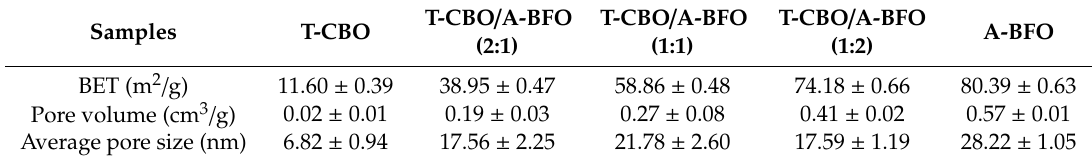
Table 1. BET surface area, pore volume, and average pore size of the